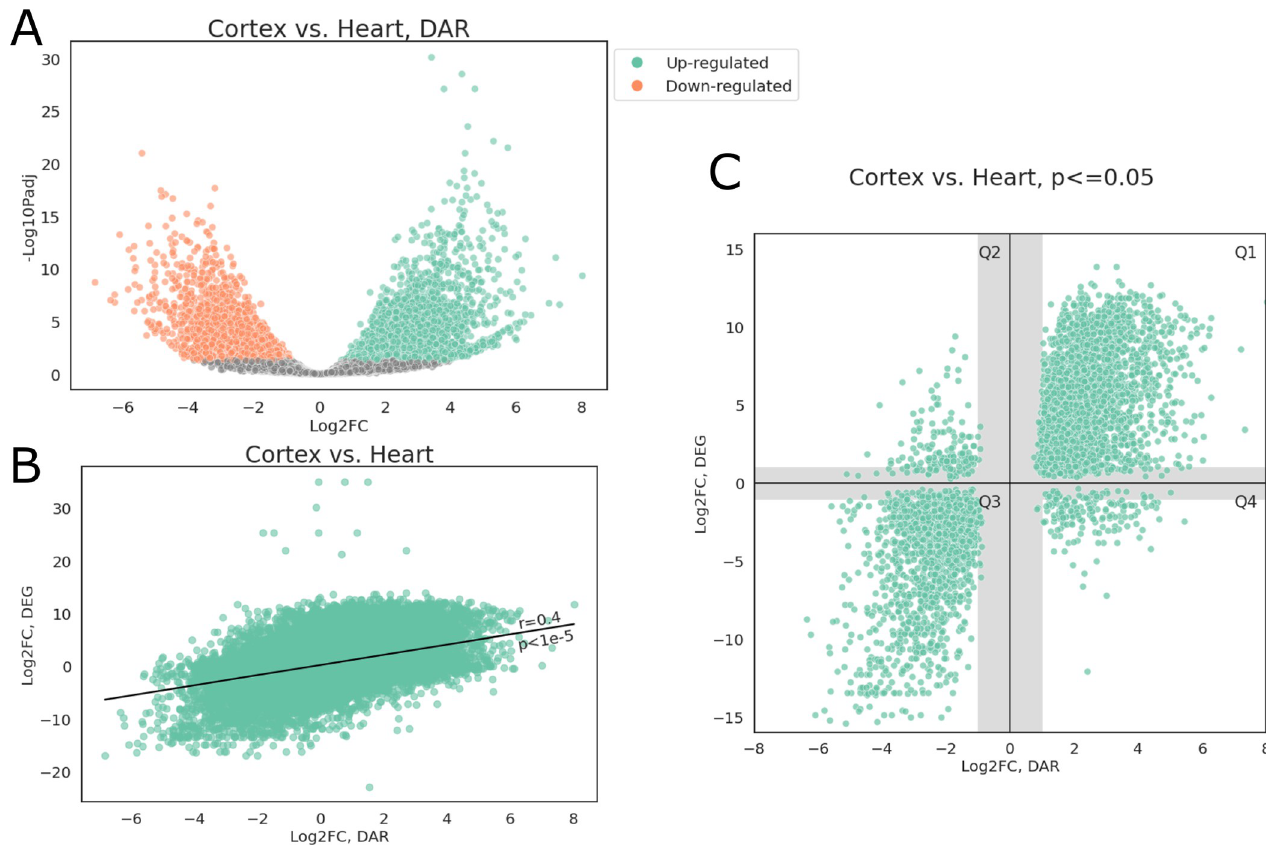
Fig 5. Differential accessibility analysis. (A) Volcano plot of open chromatin peaks; peaks with FDR adjusted p < 0.05 and |log 2 FC| > 1 were colored by direction of accessibility change, positive log 2 FC indicate greater accessibility in cerebral cortex. (B) Scatter plot of log 2 FC from DEG and DAR analyses, Pearson correlation r = 0.4. (C) Scatter plot of log 2 FC from DEG and DAR analyses, only those with both FDR adjusted p < 0.05 were plotted; shaded areas indicate regions where either FC DEG or FC DAR was under